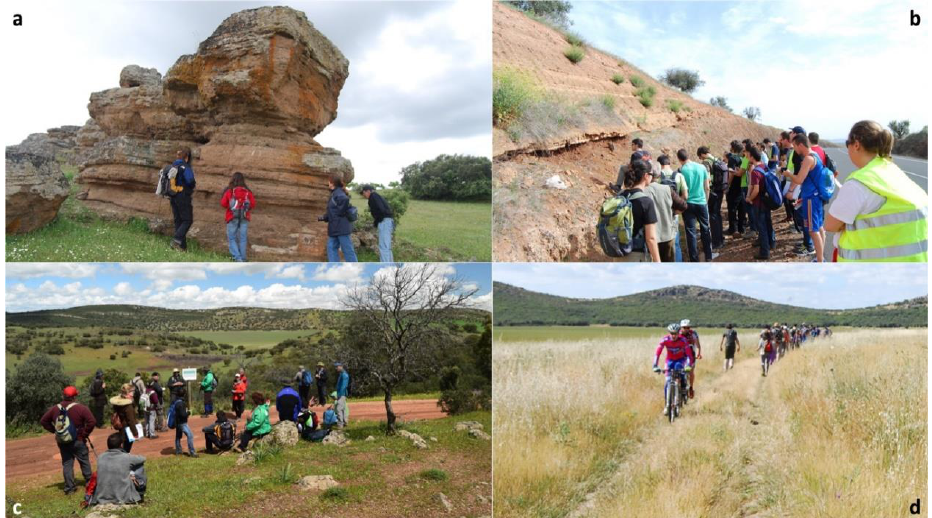
Figure 12. ( a ) Scientists studying pyroclastic flows in the La Encina maar; ( b ) university students in a workshop; ( c ) official hiking guide course in the El Acebuche maar, Calatrava Massif Natural Monument; ( d ) Biking and trekking in the Peñarroya